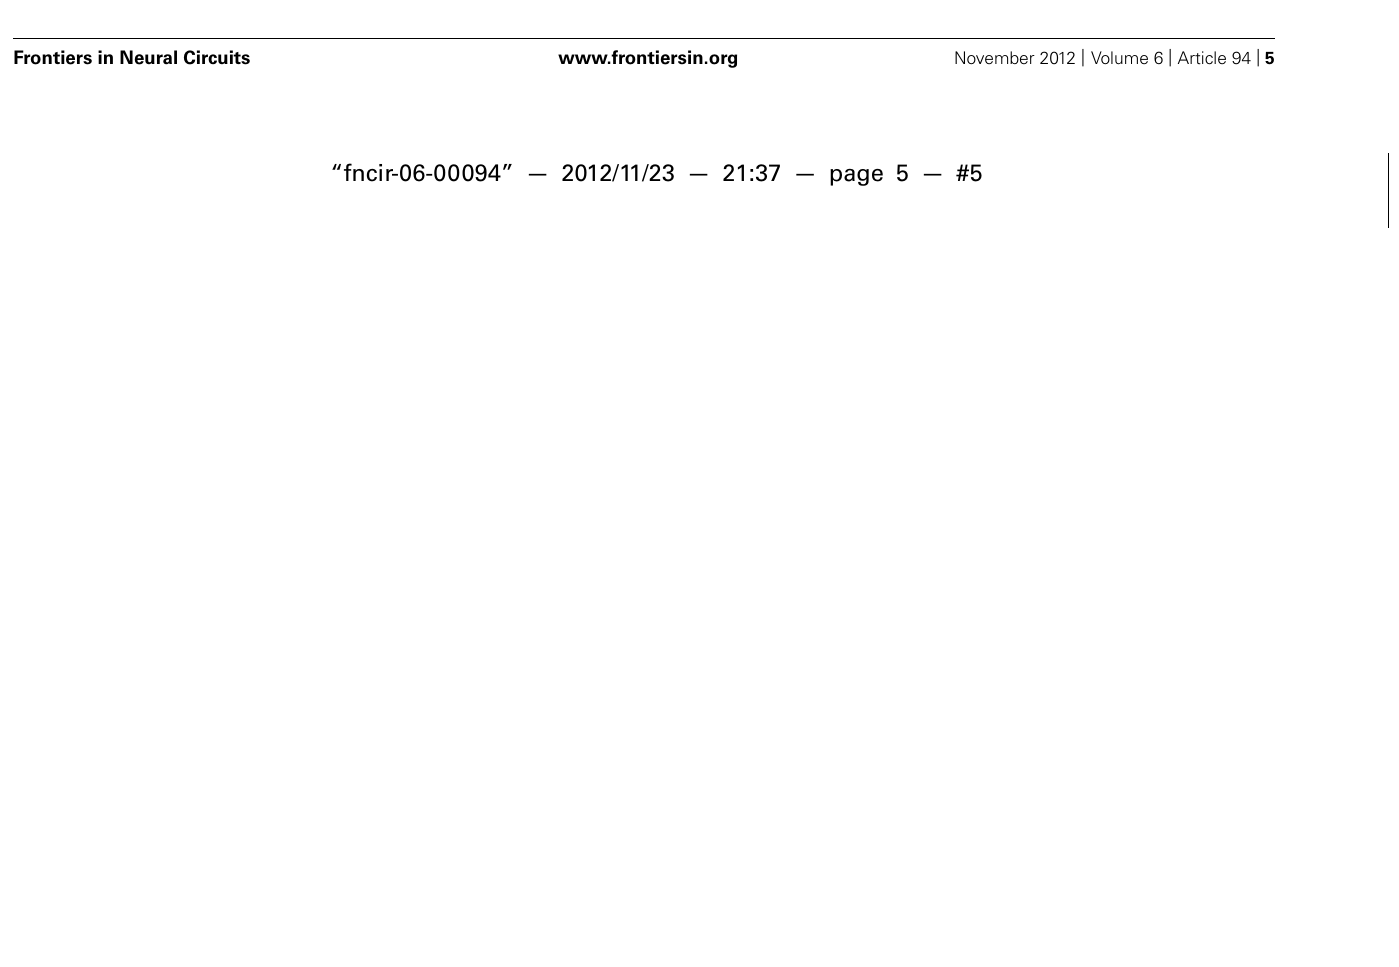
FIGURE 2 |Timestamps raster plots of spontaneously reverberating network bursts in control and during 10 nMTHDOC. The nine columns in the upper and lower panels indicate the bursts.The small vertical bars in the rows correspond to activity-timestamps from each electrode and different colors could be seen when more than one unit was identified.Time window length was 100 s. Upper : Data from a control time-segment in which up-states had a maximal duration of ∼ 1 s.The right inset illustrates the details of firing in one burst in control on a 1-s time window scale. No short bursts were seen during several hours of recording. Lower : Data recorded in the